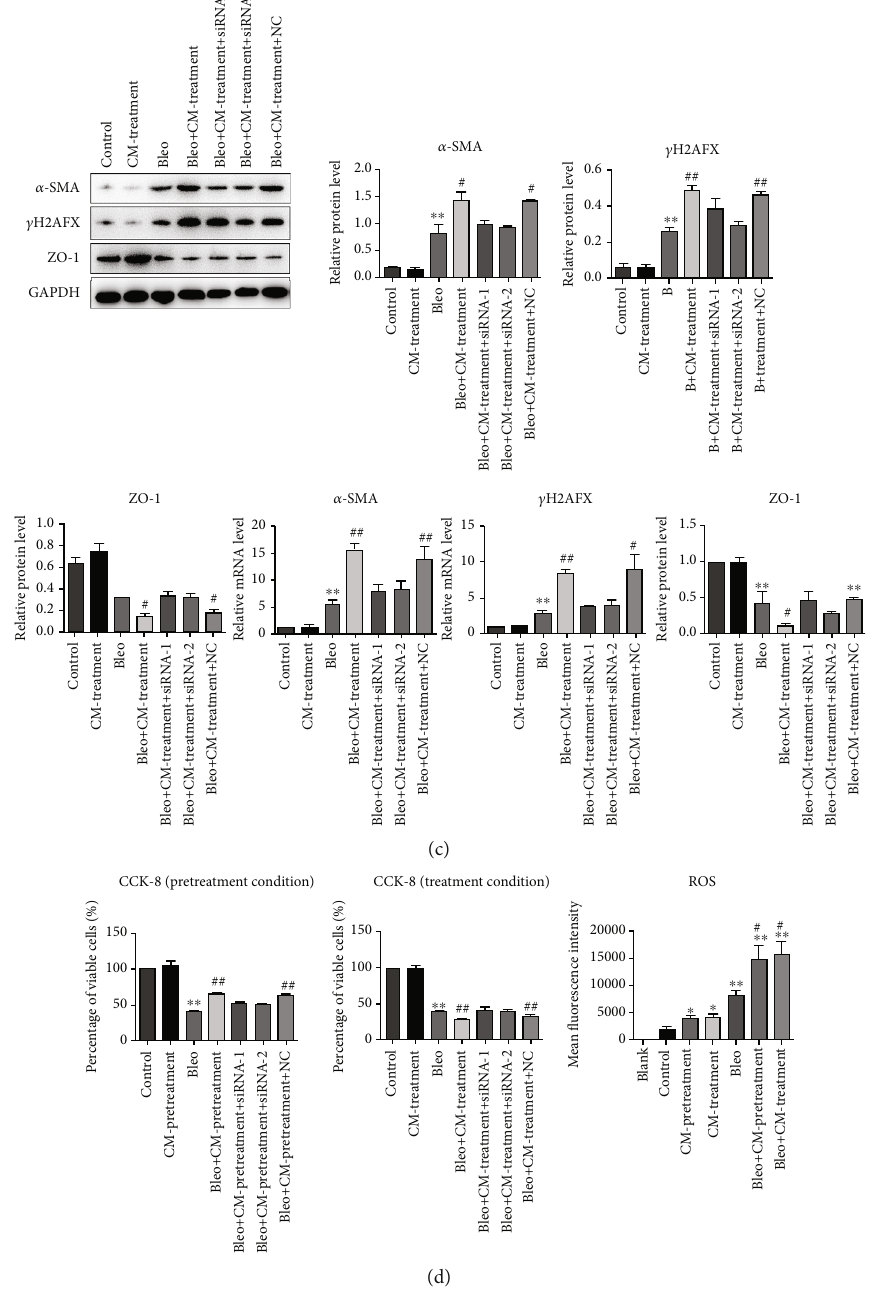
Figure 4: Analysis of several indexes in the evaluation of HUCMSC administration of bleomycin-induced pulmonary fi brosis in A549 cells. (a) HIF-1 α results and analysis of western blot and qPCR in A549 cells. (b) Cellular marker γ H2AFX, ZO-1, and α -SMA results and analysis of western blot and qPCR in the pretreatment condition. (c) Cellular marker γ H2AFX, ZO-1, and α -SMA results and analysis of western blot and qPCR in treatment condition. (d) Cell viability assays and ROS results and analysis in the pretreatment and treatment conditions. Data are presented as mean ± SEM . ∗ p ≤ 0 : 05 , ∗∗ p ≤ 0 : 01 vs. the control; # p ≤ 0 : 05 , ## p ≤ 0 : 01 vs. the